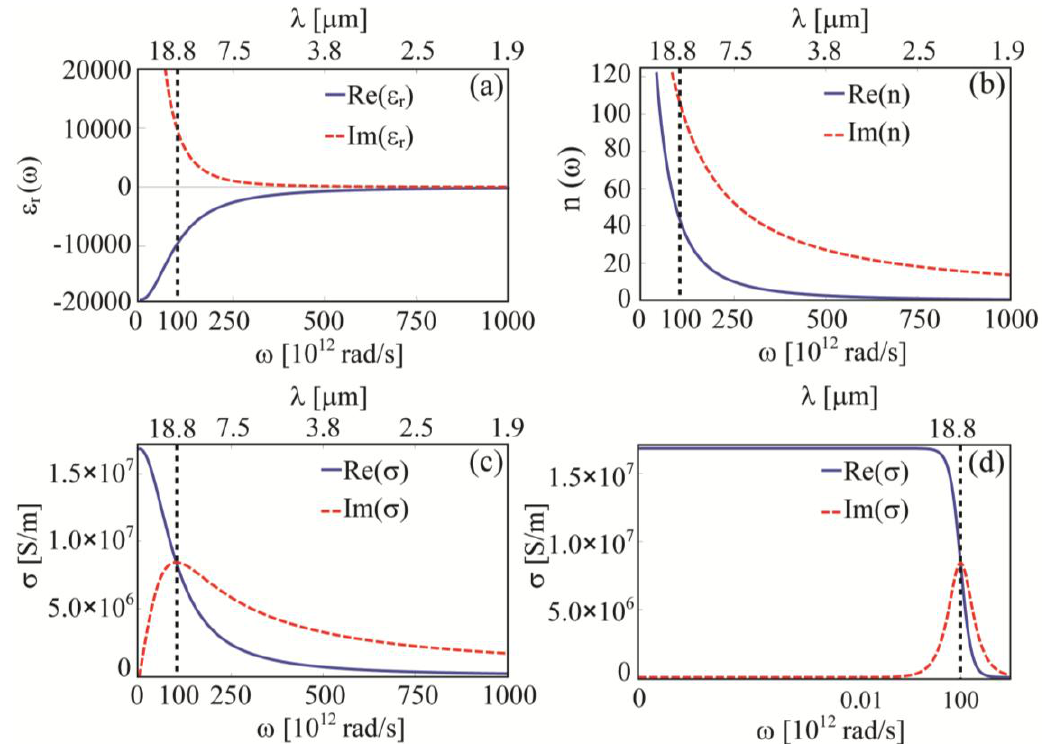
Figure 1. ( a ) Real (blue, full) and imaginary part (red, dashed) of gold relative permittivity based on Equation (8); ( b ) Real (blue, full) and imaginary part (red, dashed) of gold refractive index based on Equation (8); ( c ) Real (blue, full) and imaginary part (red, dashed) of gold conductivity based on Equation (7); the Γ parameter is highlighted; ( d ) Real (blue, full) and imaginary part (red, dashed) of gold conductivity based on Equation (7) in logarithmic scale; the Γ parameter is